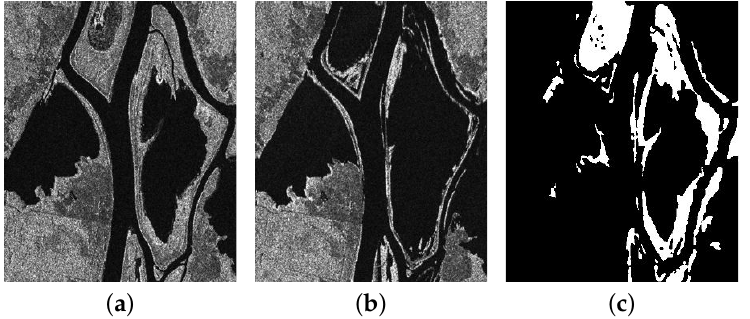
Figure 6. Ottawa dataset. ( a ) SAR image acquired in 2008. ( b ) Optical image acquired in 2010. ( c ) Reference